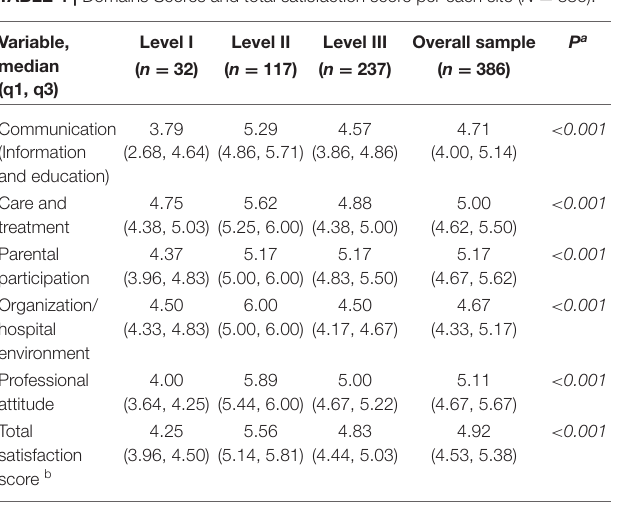
TABLE 4 | Domains Scores and total satisfaction score per each site ( N =